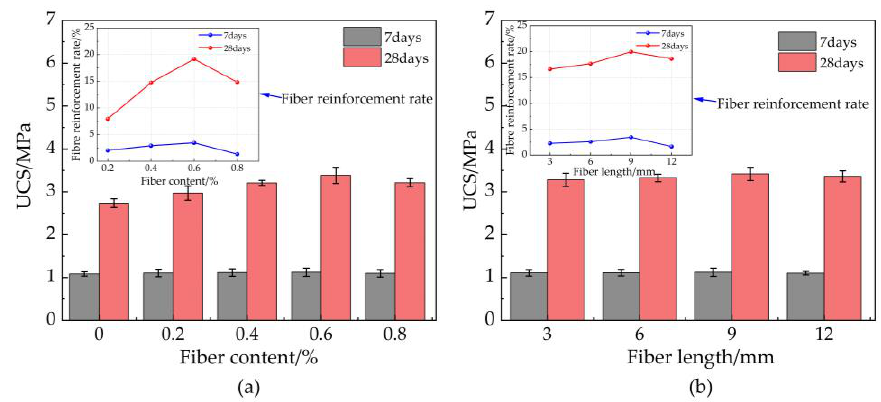
Figure 8. Effect of basalt fiber on UCS of BFBCP: ( a ) fiber content; ( b ) fiber length.